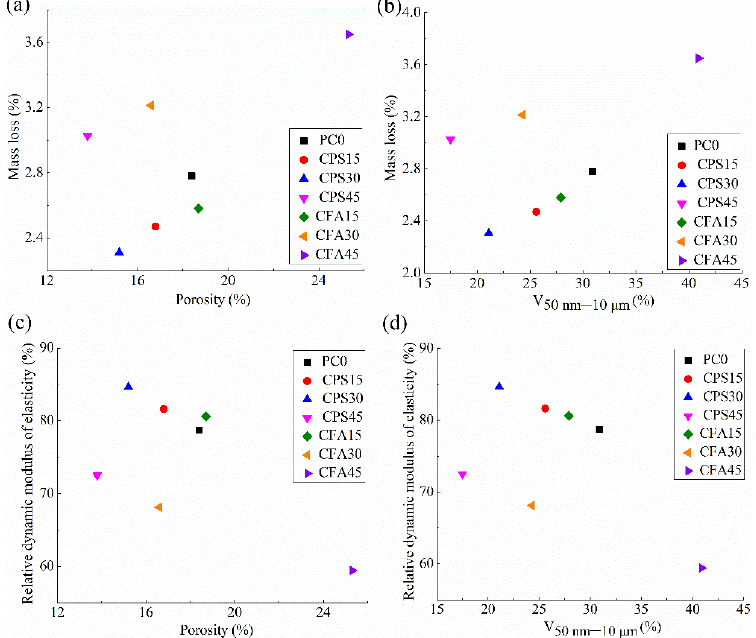
Figure 6. The correlations between frost resistance and pore structure ( a ) mass loss and porosity, ( b ) mass loss and V 50 nm – 10 μm , ( c ) relative dynamic elastic modulus and porosity and ( d ) relative dynamic ( b ) mass loss and V 50 nm–10 µ m , ( c ) relative dynamic elastic modulus and porosity and ( d ) relative elastic modulus and V 50 nm – 10 μm . dynamic elastic modulus and V 50 nm–10 µ m